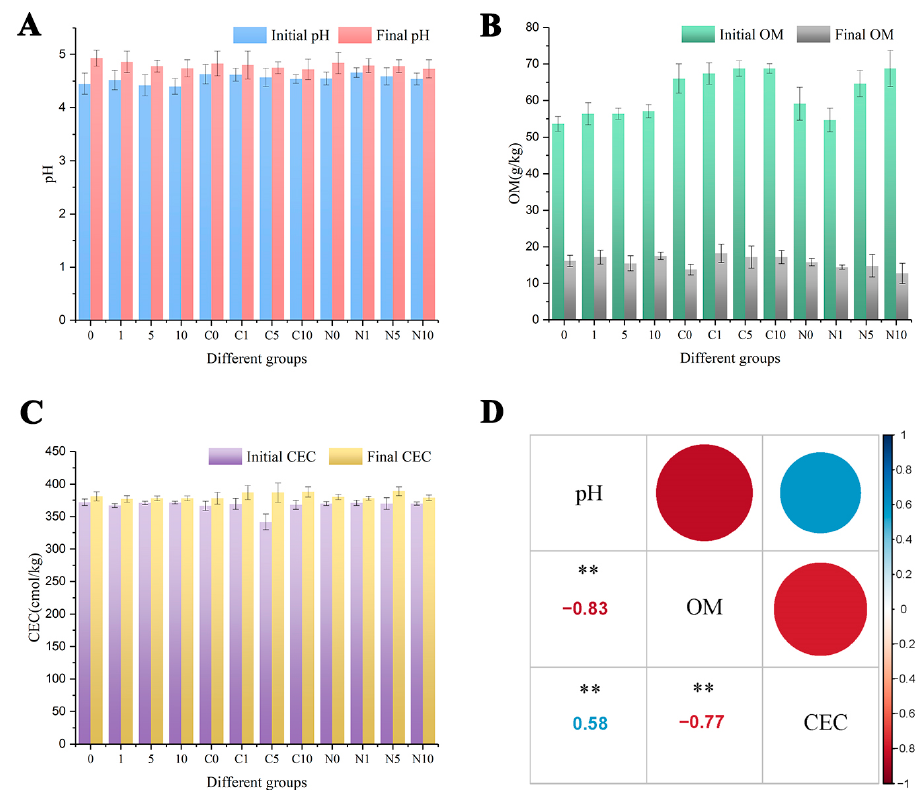
Figure 6. ( A ) The changes in soil pH before and after incubation. ( B ) The changes of OM in the soil. ( C ) The changes of CEC under different treatments before and after incubation. All values represent the mean ± SE, n = 3. The one-way ANOVA indicates the significant differences at p < 0.05 according to Tukey test. ( D ) The correlation among pH, OM and CEC. “**” means that the correlation at the 0.01 level is significant.